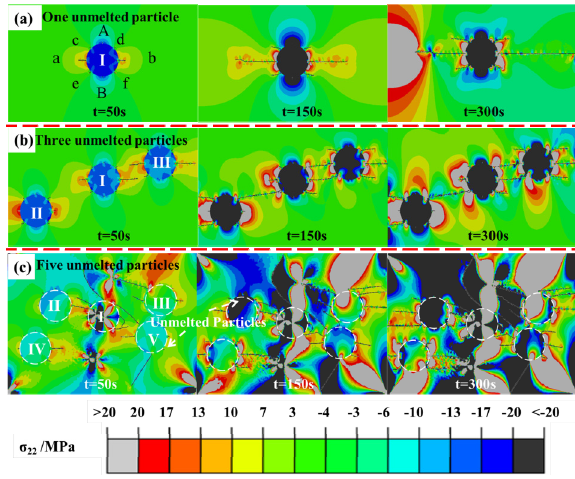
Figure 8. Crack propagation and σ 22 stress distribution in coatings with various UNCs, ( a ) one UNPs; ( b ) three UNPs; ( c ) five UNPs.